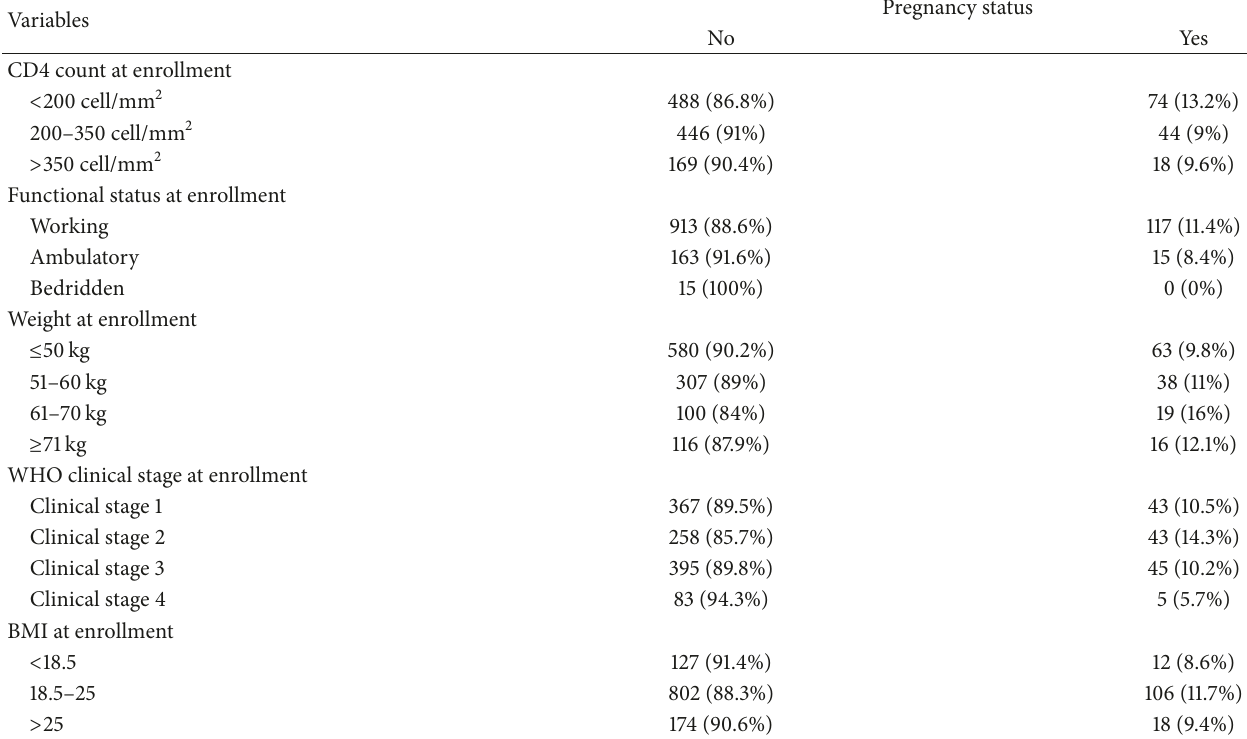
Table 2: Clinical characteristics of women receiving ART treatment in Debre Markos Referral Hospital, Northwest Ethiopia, Sep. 2011 to Aug. 2015 (𝑁 = 1239)